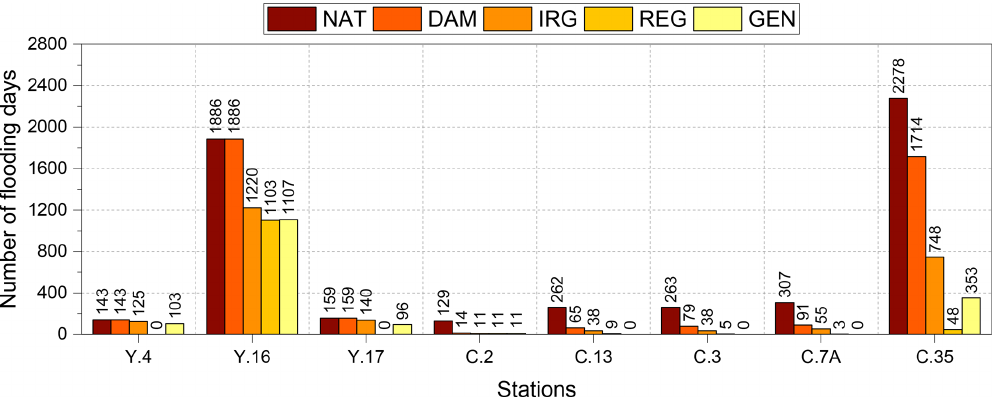
Figure 8. The number of days the daily discharge exceeded the channel carrying capacity from 1980–2004 (25 years) at various locations (refer to Fig. 4 for the channel carrying capacity of each station) under different